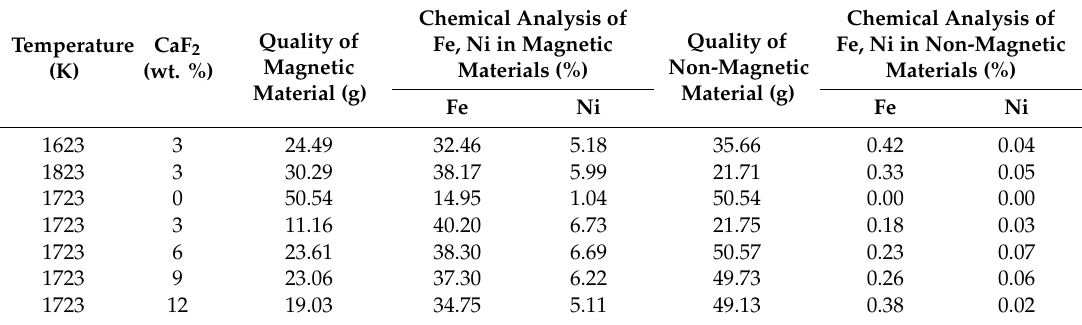
Table 4. The content and recovery of Fe and Ni using the magnetic separation process and using the vacuum carbothermal reduction–magnetic separation process.